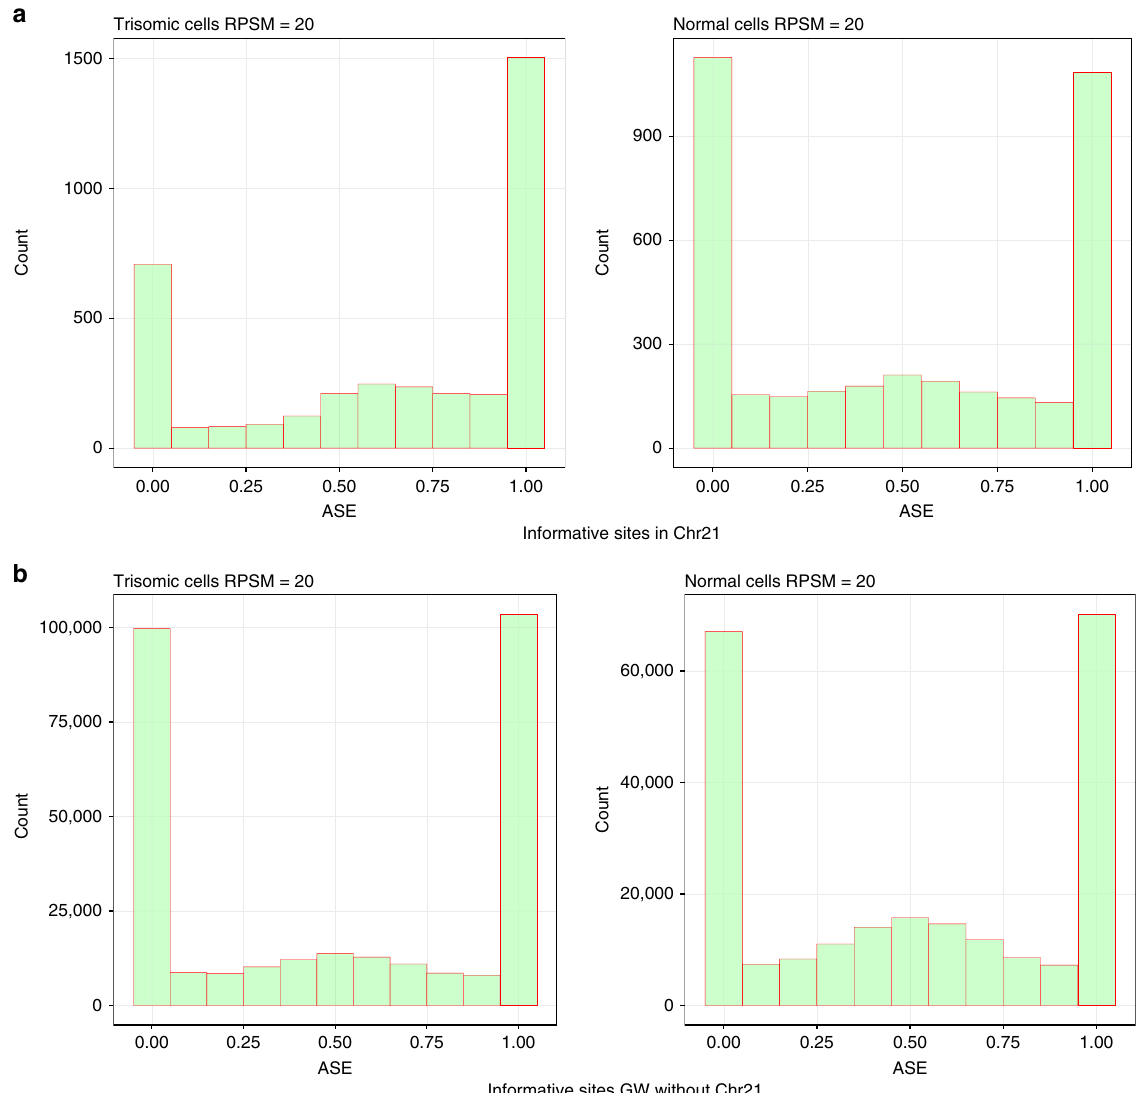
Fig. 1 Histogram of SC ASE observations in Monozygotic Twins Discordant for DS. a Histogram of ASE observations in chr21 in single cells. Similarly to genome-wide observations, monoallelic ASE in chr21 is prevalent (46.5% diploid – 59.39% trisomic. Notably, for trisomic SC, monoallelic ASEs on chr21 of the double allele (0.9-1) are twice as many of monoallelic ASEs of the single allele (0 – 0.1). Moreover biallelic observations in trisomic single cells are not centered at 0.5 as in diploid single cells, but at 0.66 (2/3). a Histogram of genome-wide ASE observations in SC excluding chr21 (Blue = diploid Twin, Red = trisomic Twin). High prevalence of monoallelic ASE observations was observed for both groups (60.14% diploid – 70.3% trisomic). Source data are provided in the public